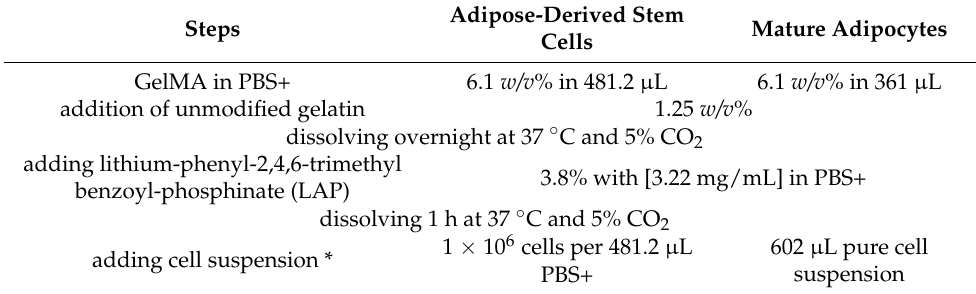
Table 2. Cell-containing GelMA composition. Adipose-Derived Stem Steps Mature Adipocytes Cells GelMA in PBS+ 6.1 w/v % in 481.2 µ L 6.1 w/v % in 361 µ L addition of unmodified gelatin 1.25 w/v